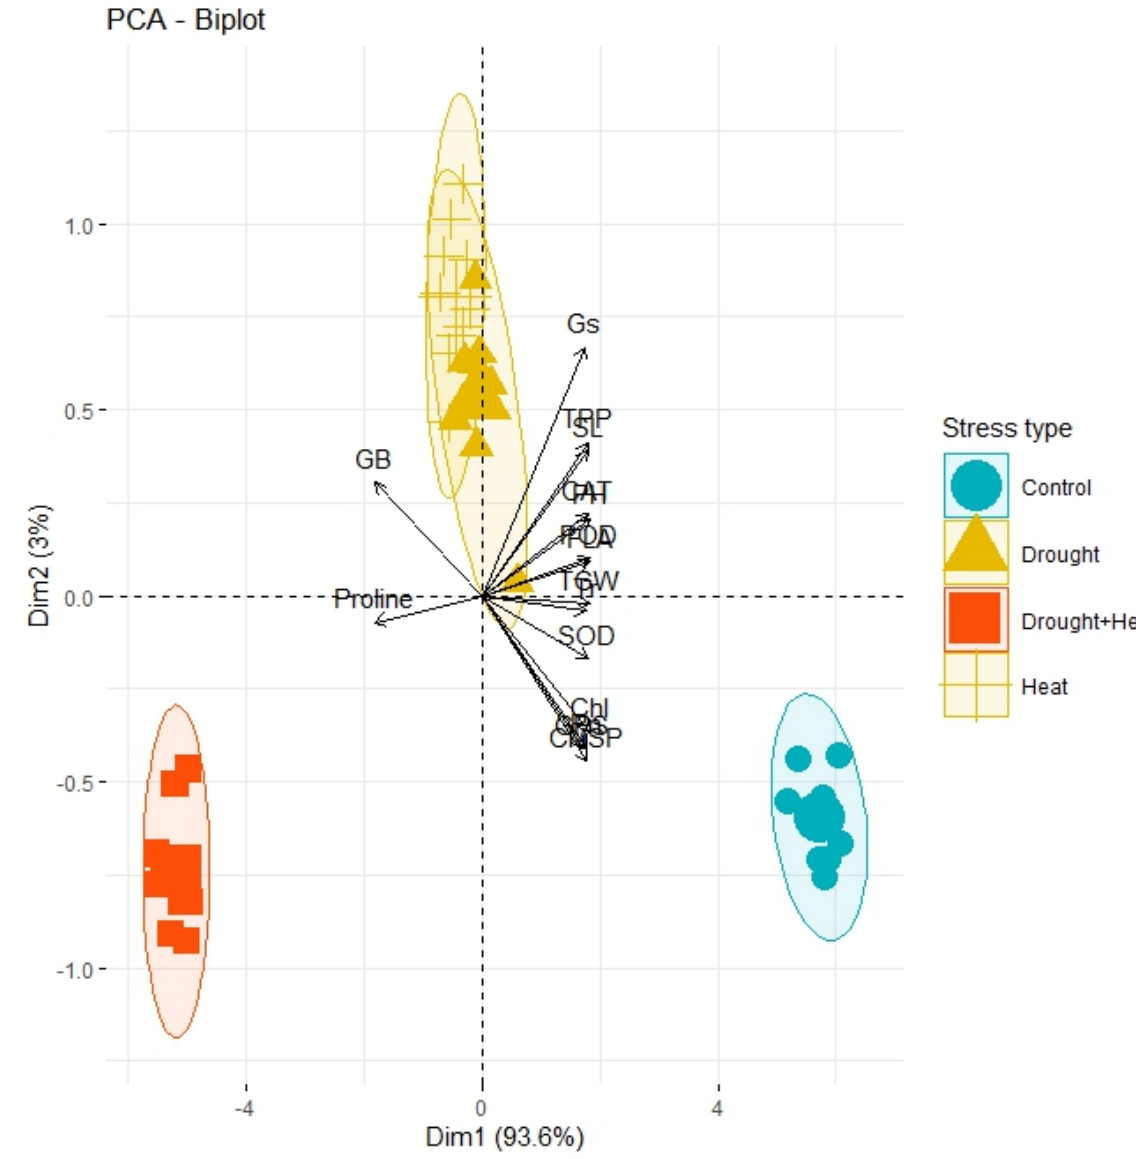
Figure 2. PCA plot showing the differential divergence of treatments circles with respect to proximity association of physiological, biochemical, and agronomic traits while extent of divergence of circles is directly associated with variation in the effect of treatments. Pn; photosynthesis, Gs; stomatal conductance, Tr; transpiration rate, CMSP; cell membrane stability percentage, GB; glycine betaine, SOD; superoxide dismutase, POD; peroxidase, CAT; catalase, FLA; flag leaf area, PH; plant height, TPP; tiller per plant, SL; spike length, GPS; grains per spike, TGW; thousand grain weight.